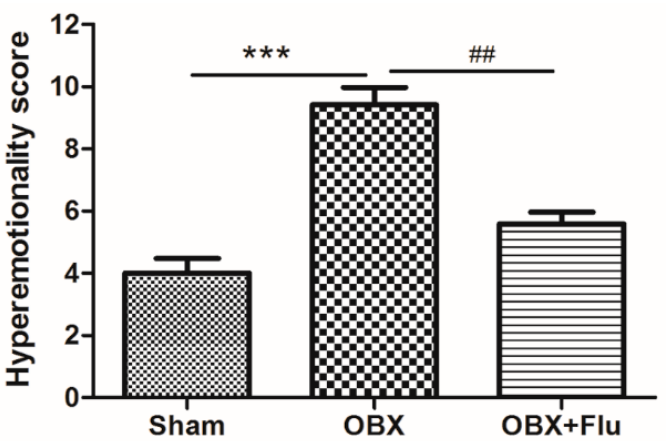
Figure 2. The effects of OBX and fluoxetine treatment on the hyperemotionality score in rats. *** p < 0.001 compared to the sham group. ## p < 0.01 compared to the OBX group (means ± SEM, n = 8). Flu, fluoxetine. OBX, olfactory bulbectomy.